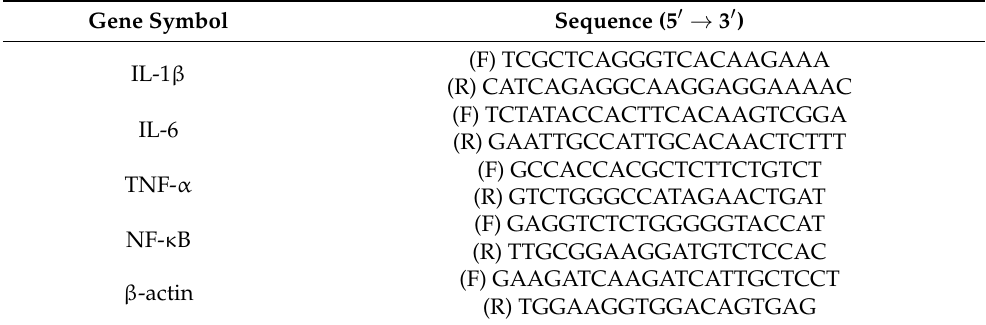
Table 1. Primers used for